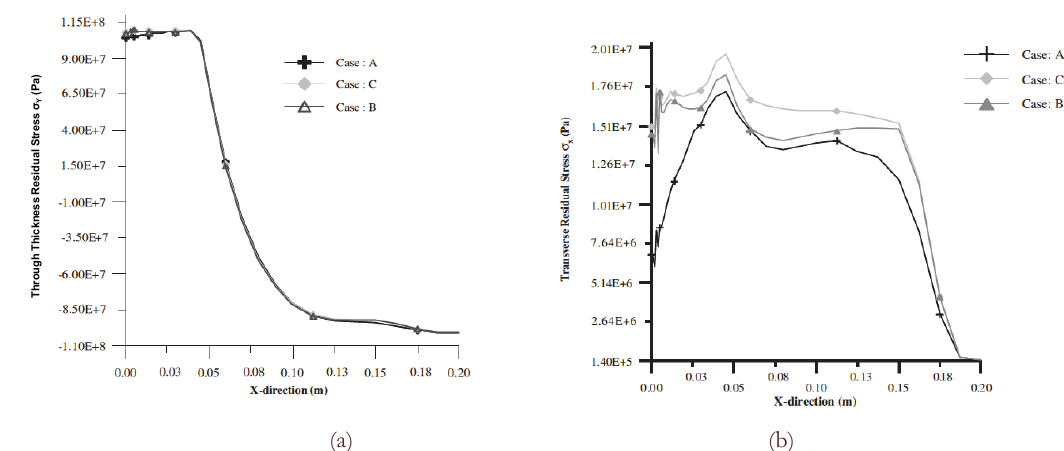
Figure 6: Predicted residual stress components along (a) Y direction (b) X direction , for three cases of welding sequences